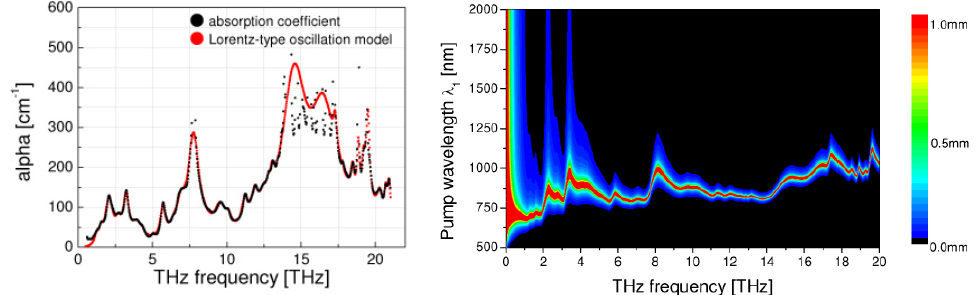
Figure 19. THz absorption coefficient and coherence length distribution of BNA-DFG, with a type-0 phase-matching configuration [38].